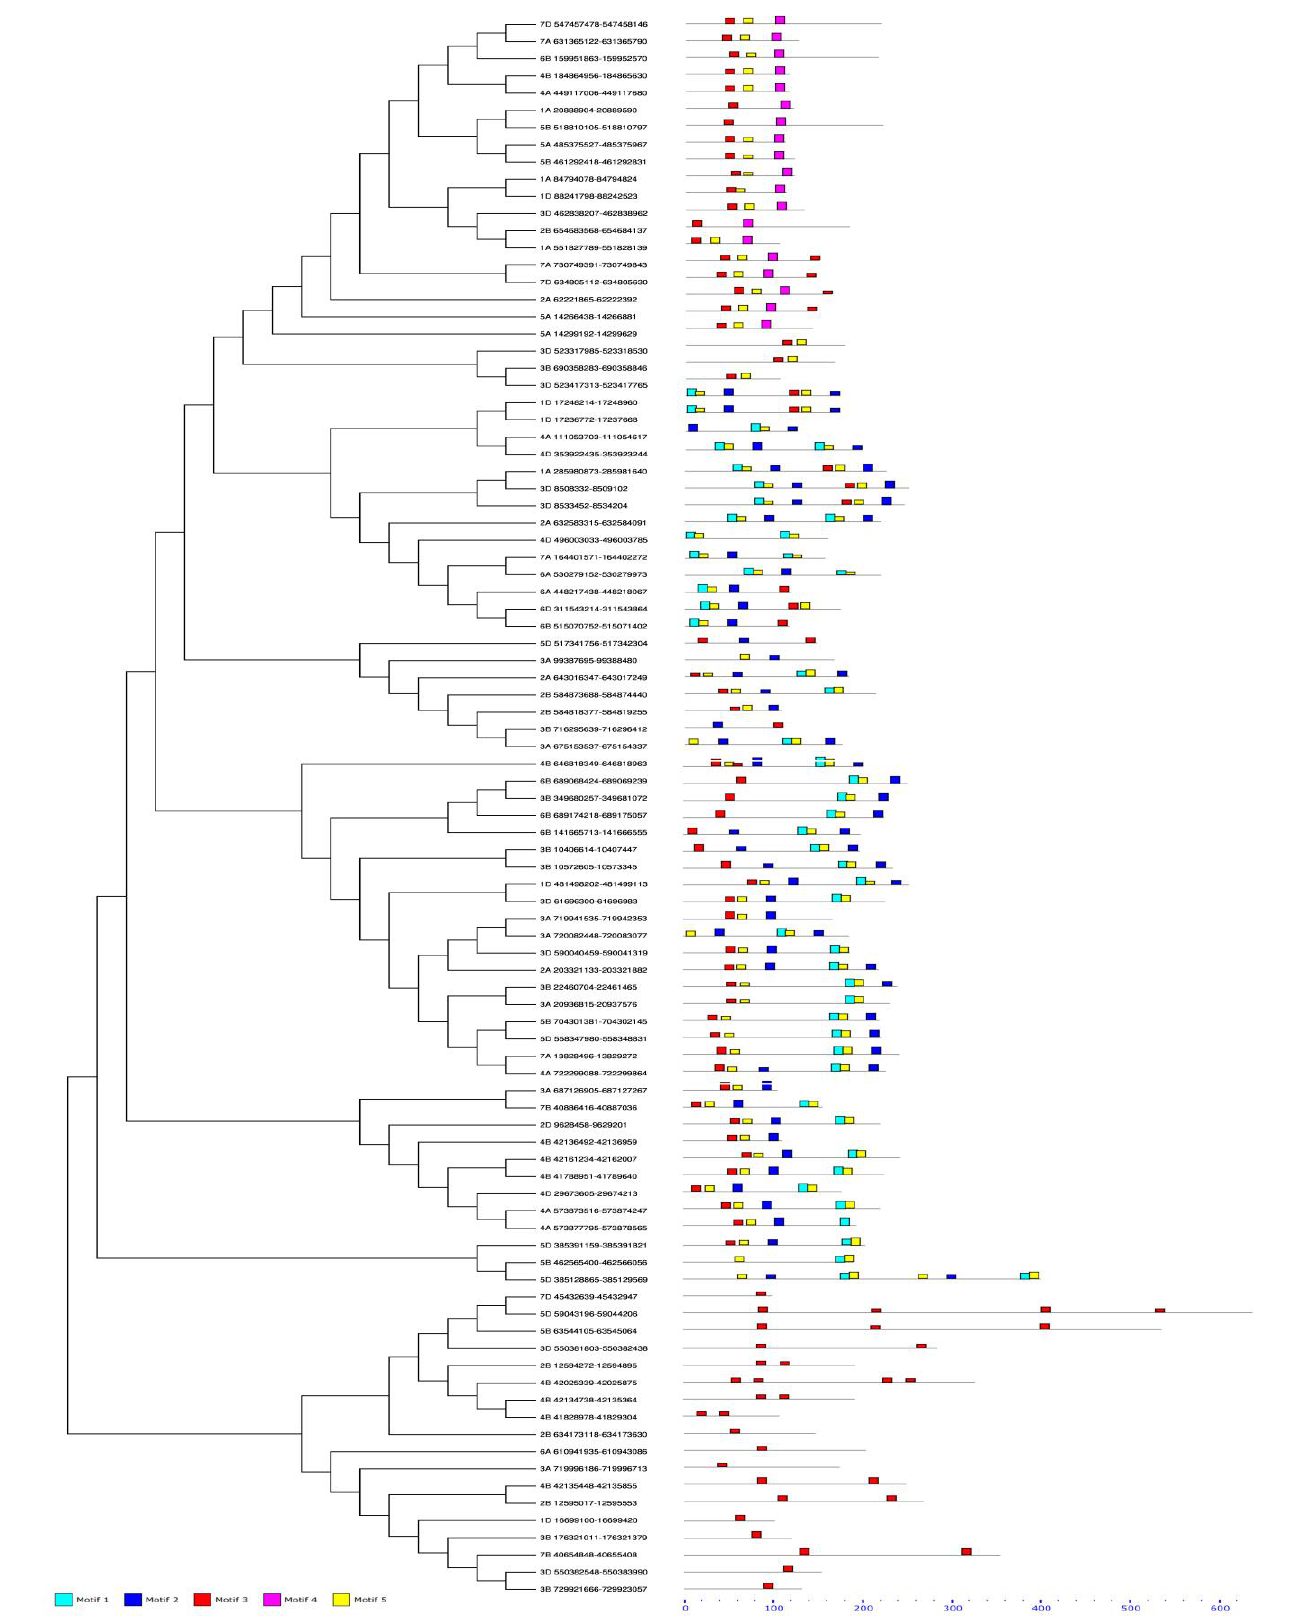
Figure 4: The phylogenetic tree developed using multiple sequence alignment of predicted anti-fungal genes as compared to the expected positions of protein